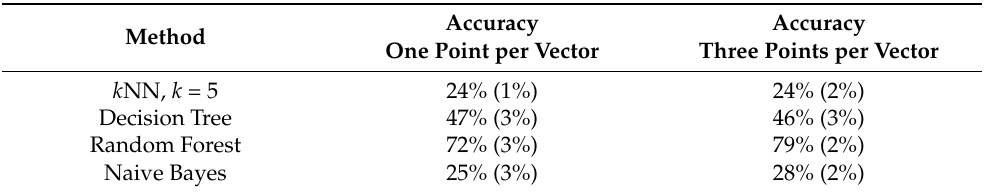
Table 1. The averaged accuracy obtained on the feature vector level for the four classification methods. The standard deviation is provided in